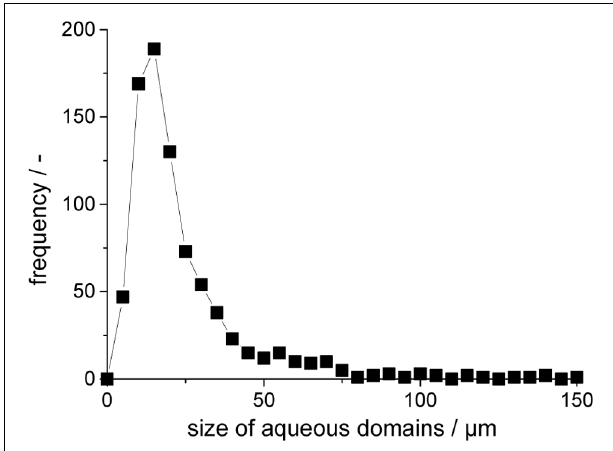
FIGURE 3 | Size distribution of aqueous inclusions in the polyurethane